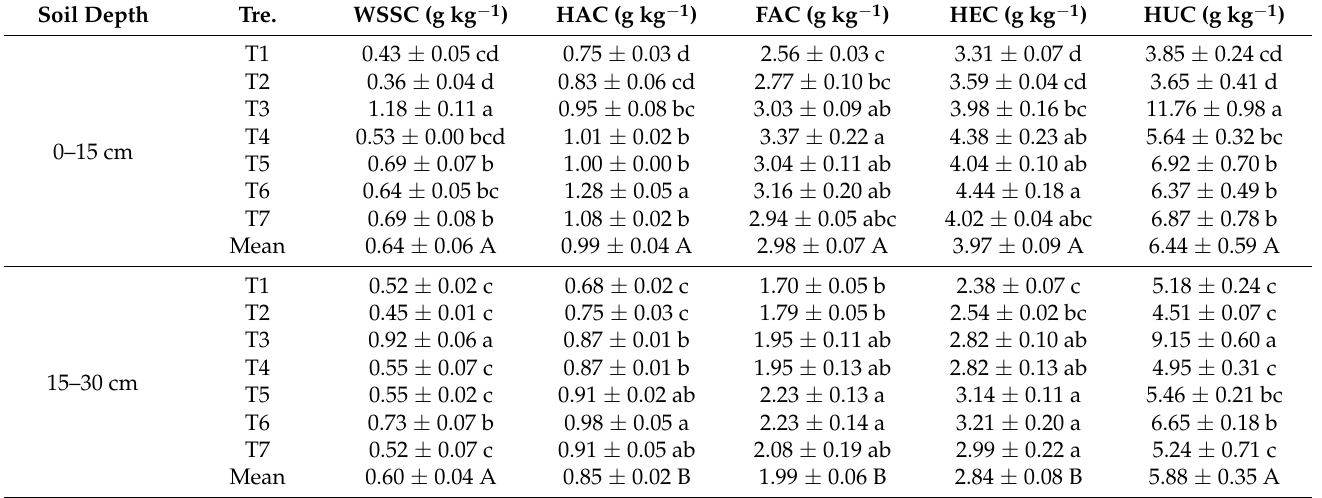
Table 2. Water-soluble substance carbon (WSSC), humic acid carbon (HAC), fulvic acid carbon (FAC), total alkali-extractable humus carbon (HEC) and humin carbon (HUC) contents at 0–15 and 15–30 cm depths as affected by different treatments in 2020 after 12 years of annual fertilization. T1: N application by farmers (240 kg N ha − 1 ); T2: optimized N management (Nopt); T3: biochar + Nopt; T4: straw + Nopt; T5: manure + Nopt; T6: compost + Nopt; T7: biogas residue + Nopt. Lower-case letters indicate significant differences among treatments at a specific soil depth at p < 0.05 level. Capital letters indicate significant differences between the two soil depths at p < 0.05